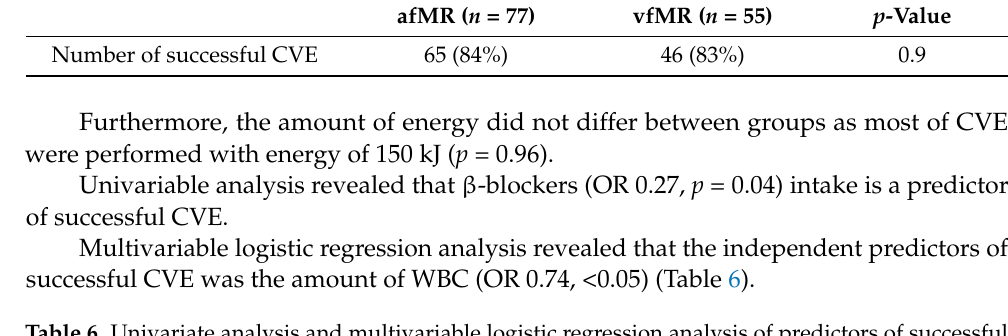
Table 6. Univariate analysis and multivariable logistic regression analysis of predictors of successful electrical